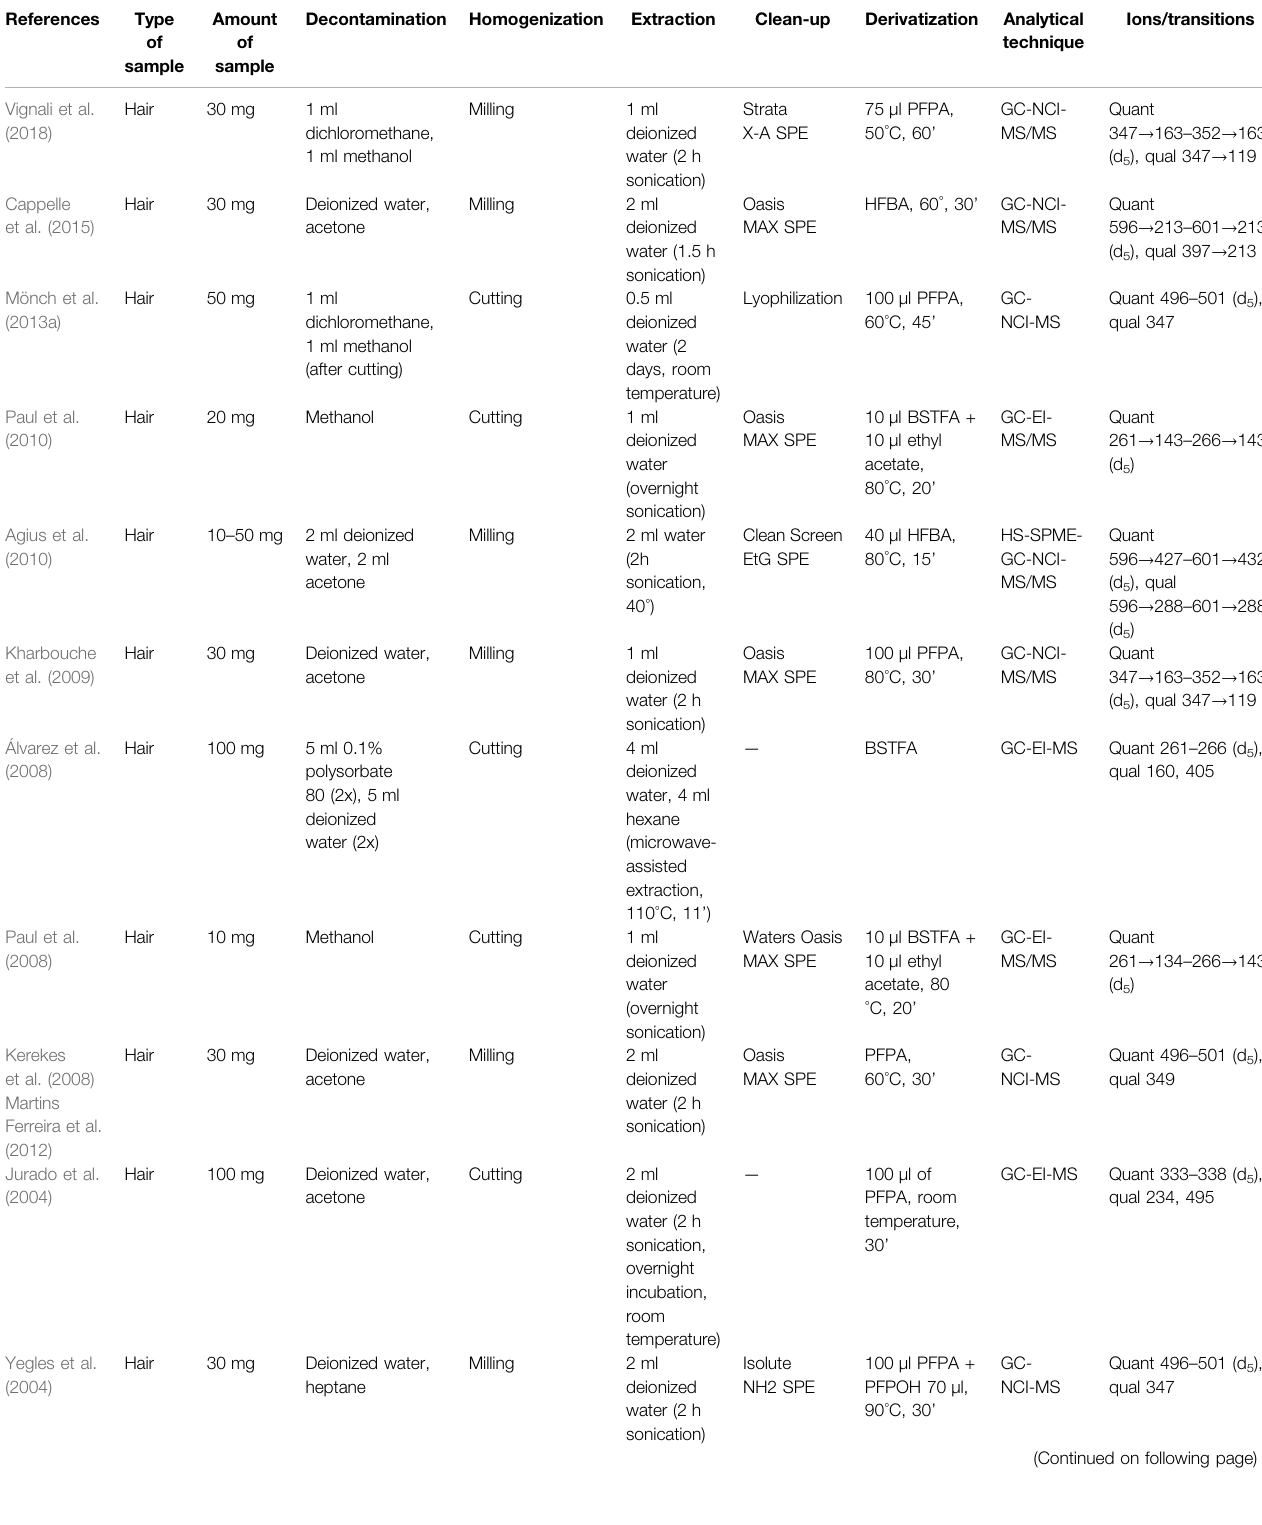
TABLE 1 | Overview of the available methods to carry out EtG quanti fi cation in